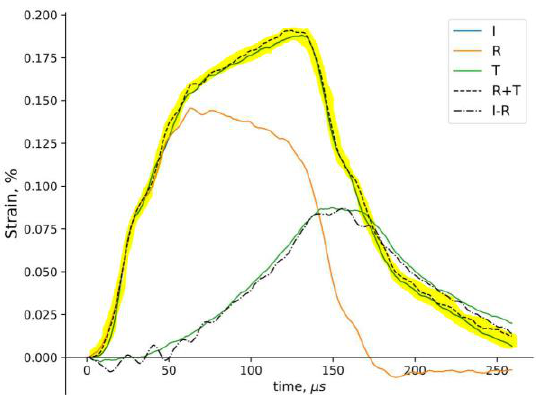
Figure 9. Example of graphical representation of the fulfillment of dynamic stress equilibrium condition (reprinted from Ref. [59]).